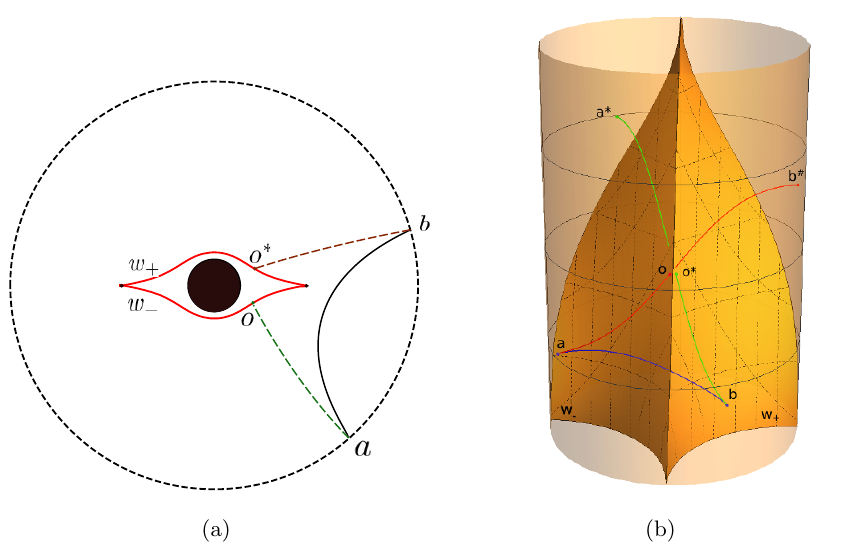
Figure 9 . (a) Illustration of projection of direct and crossing geodesics on a time slice at t > 0. The solid black curve is a direct geodesic between a and b . The dashed curves are pieces of the crossing geodesic between a and b . (b) A plot of direct geodesic and image geodesics which constitute the crossing geodesic in the 3D global black hole rest frame picture. The BTZ identi(cid:12)cation surfaces as well as apparent horizon are not drawn to avoid